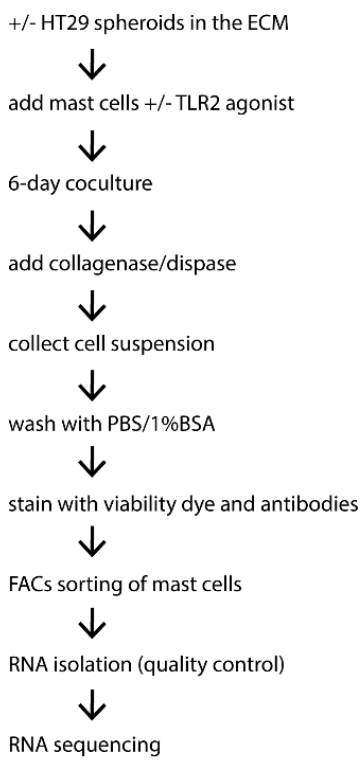
Figure 4. Brief overview of the experimental procedure to obtain mast cell RNA samples from the 310 coculture with colon cancer spheroids. 311